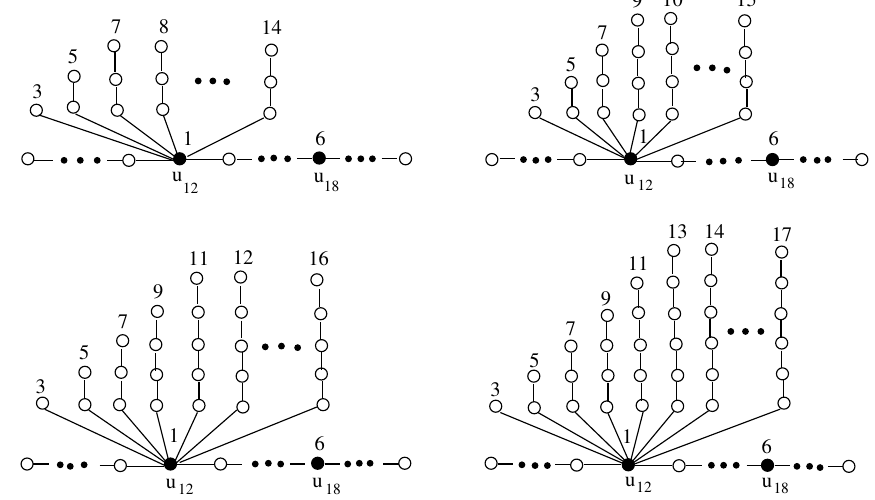
Figure 4: Four non-isomorphic minimal trees T with diam( T ) = 23 and ˜ γ ( T ) = 12